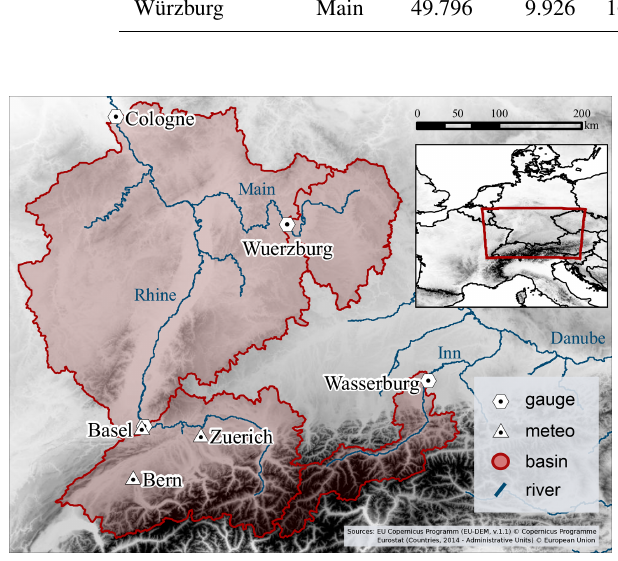
Figure 1. Topographic map of the study area with the locations of river gauges, river basins and meteorological